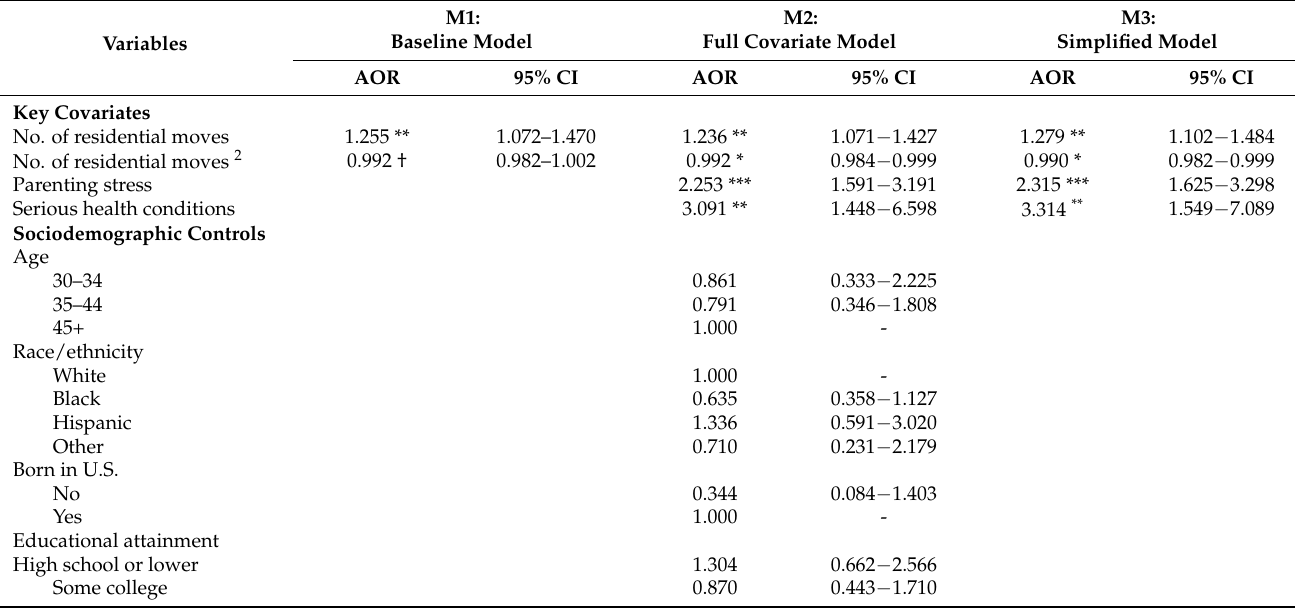
Table 2. Weighted percentages of housing arrangements among US mothers following a nonmarital birth, Fragile Families and Child Wellbeing Study (n = 2279). Table 3. The effects of 15-year cumulative residential moves on past-year major depressive episodes among US mothers following a nonmarital birth, Fragile Families and Child Wellbeing Study ( n =